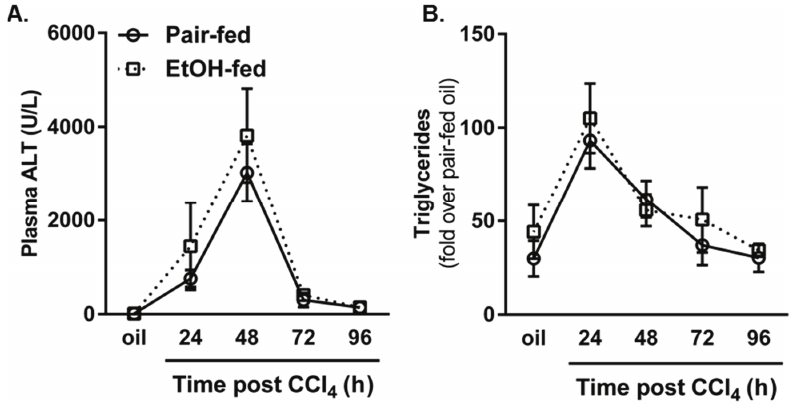
Figure 2. CCl 4 -induced liver injury and steatosis were not affected by ethanol feeding to mice. Mice were allowed free-access to a 2% ( v / v ) ethanol containing diet for two days and then were exposed to CCl 4 and euthanized 24, 48, 72 or 96 h thereafter, while remaining on the ethanol diet. Control animals were pair-fed a diet that isocalorically substituted maltose dextrins for ethanol. ( A ) Plasma ALT was used to determine hepatic injury; ( B ) A biochemical assay was used to quantify hepatic triglyceride content. N = 4–8 mice per group.